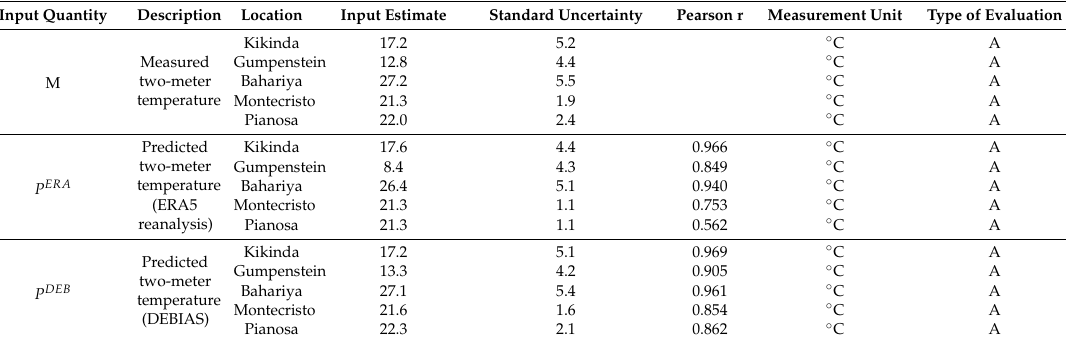
Table A2. Input estimates and standard